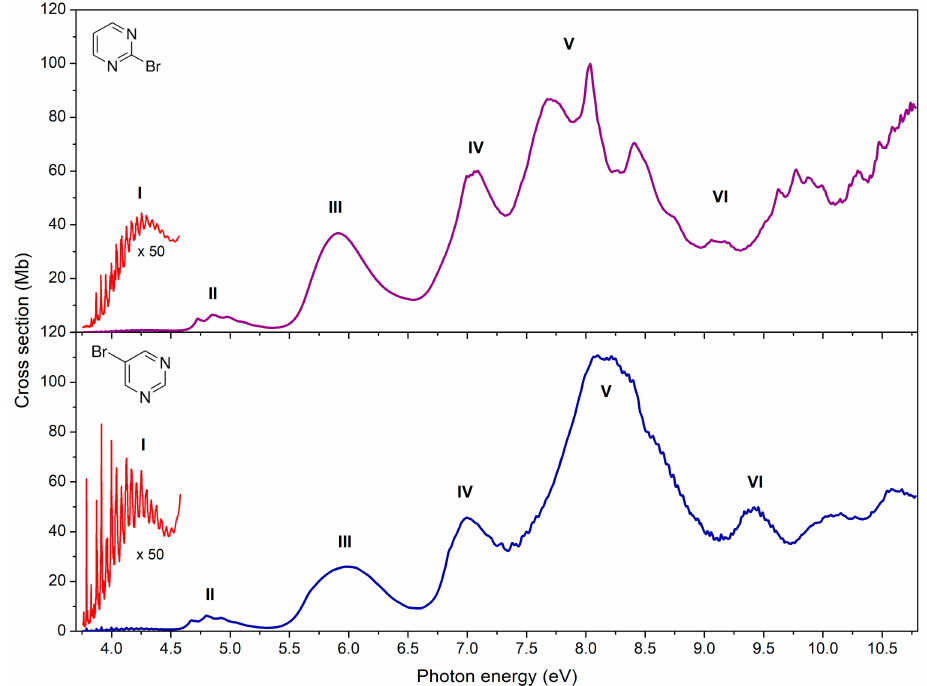
Figure 4. High-resolution VUV photoabsorption spectrum of 2-bromopyrimidine ( top panel) and 5-bromopyrimidine ( bottom panel) in the 3.7–10.8 eV photon energy range. Appropriate band labels (I–VI) are also given. See text for